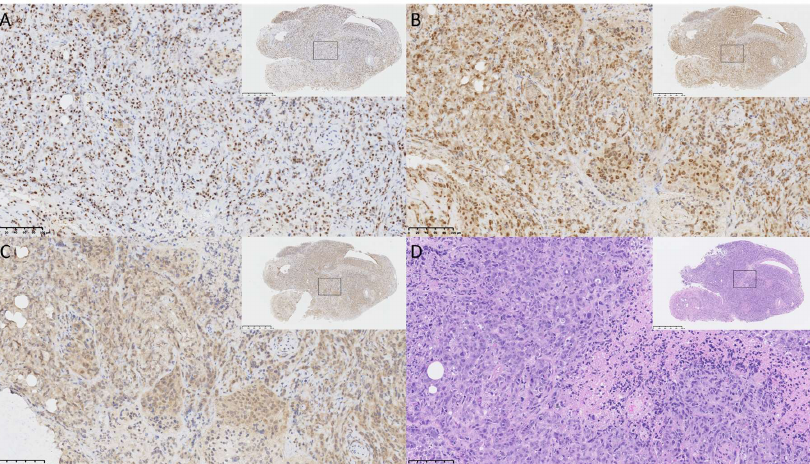
Figure 4. Immunohistology of OVCAR8 luc xenografts, using antibodies specific for ( A ) WT1; ( B ) Figure 4 PAX8; ( C ) HIF1- α or ( D ) after staining with H&E. Xenografts were obtained from mice at 56 days post-inoculation of 5 million cells. Slides were depara ffi niated and stained with appropriate antibodies or stain as described in the methods. Figures show representative images of tumor sections collected from mouse 5k at 20 × magnification, scale bar equal to 100 µ m. Inserts show 4 × magnification of the same tumor section, scale bar equal to 500 µ